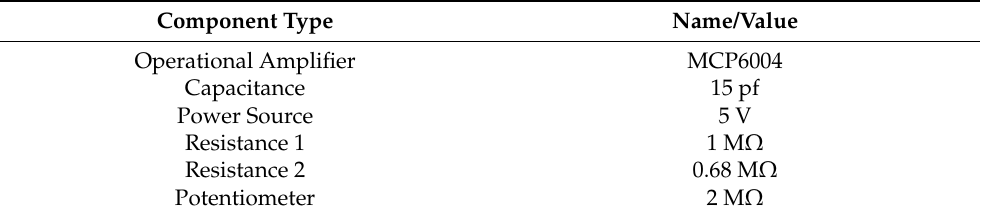
Table 1. Components used in the PCB design for sensing of the voltage drop across the